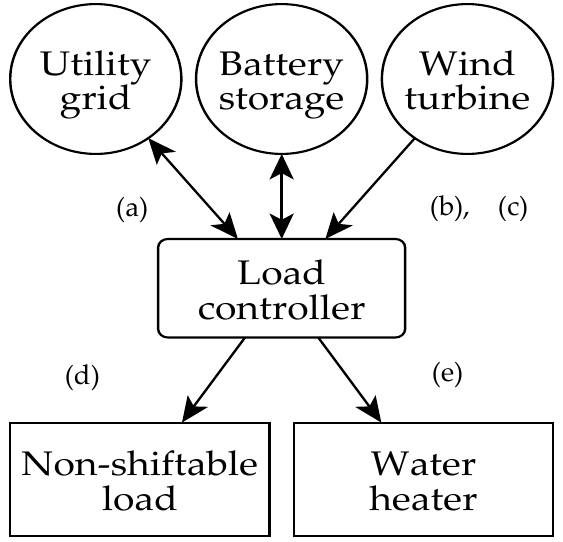
Figure 2. Configuration of microgrid (MG). ( a ) bidirectional energy flow between load controller and UG, ( b ) bidirectional energy flow between load controller and battery, ( c ) one directional energy flow from WG to load controller, ( d ) one directional energy flow from load controller to NS, ( e ) one directional energy flow from load controller to